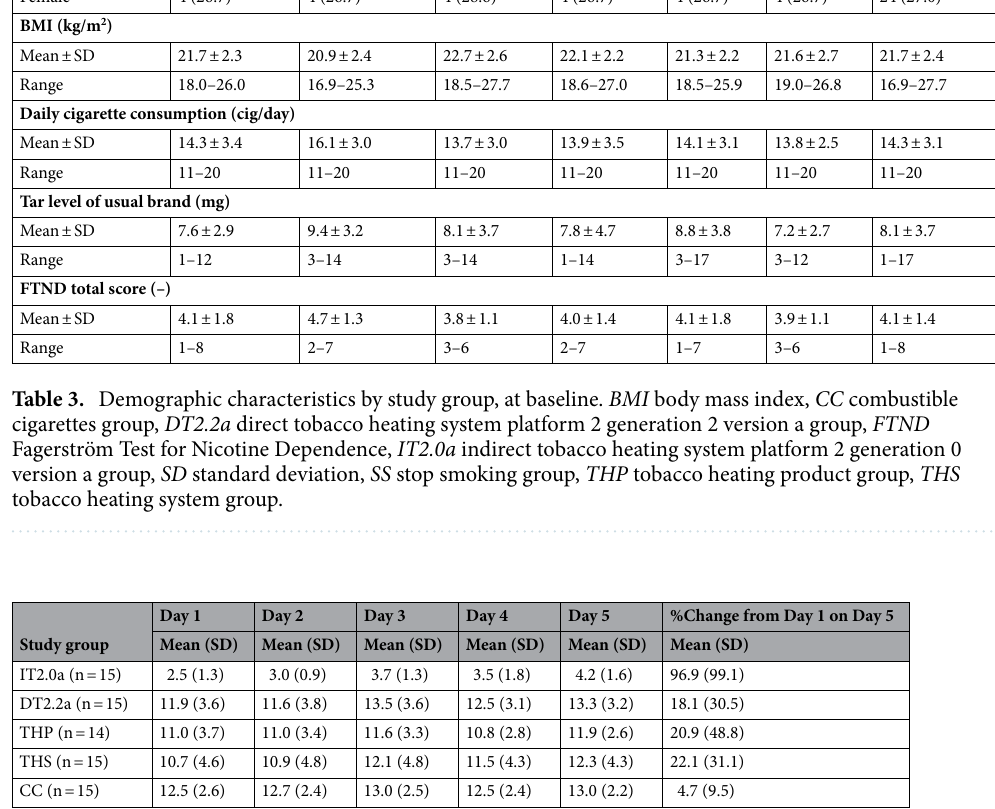
Table 4. Product consumption in each study group (consumables/day). CC combustible cigarettes group, DT2.2a direct tobacco heating system platform 2 generation 2 version a group, IT2.0a indirect tobacco heating